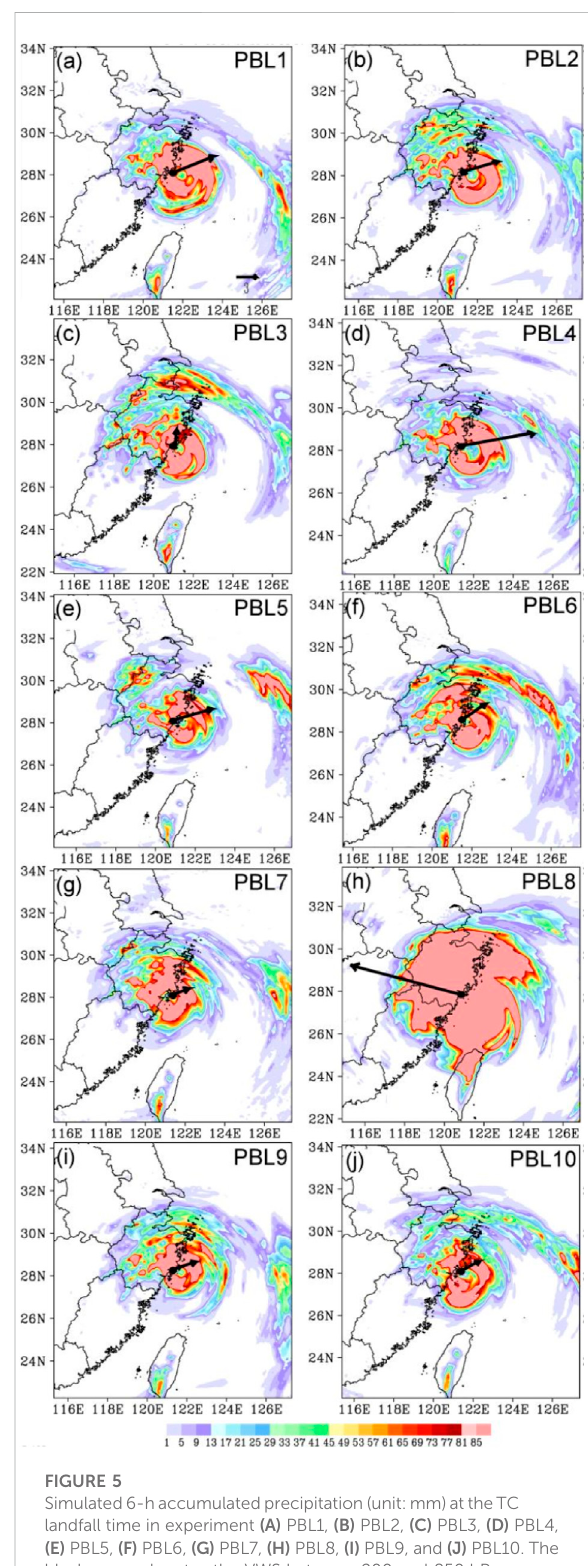
FIGURE 5 Simulated6-haccumulatedprecipitation(unit:mm)attheTC landfall time in experiment (A) PBL1, (B) PBL2, (C) PBL3, (D) PBL4, (E) PBL5, (F) PBL6, (G) PBL7, (H) PBL8, (I) PBL9, and (J) PBL10. The black arrow denotes the VWS between 200 and 850 hPa, with black dots indicating the center of